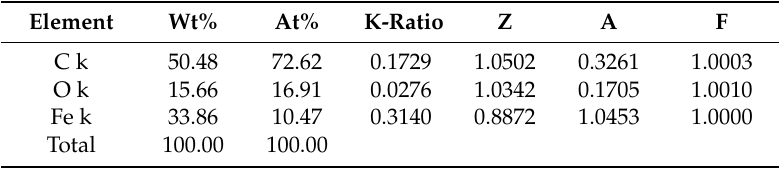
Figure 6. TEM micrograph of Fe 3 O 4 @C matrix. ( A ) magnification 220 Kx; ( B ) magnification 300 Kx.